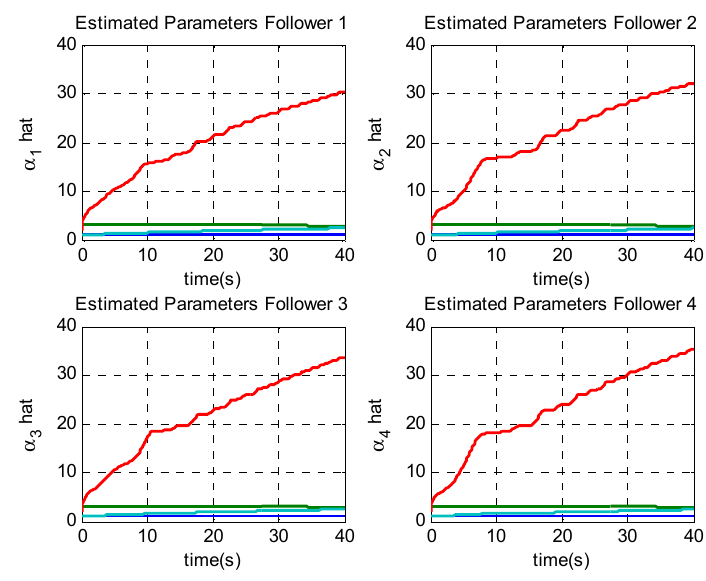
α α ˆ . Figure 17. Estimated value of the vector ˆ i i